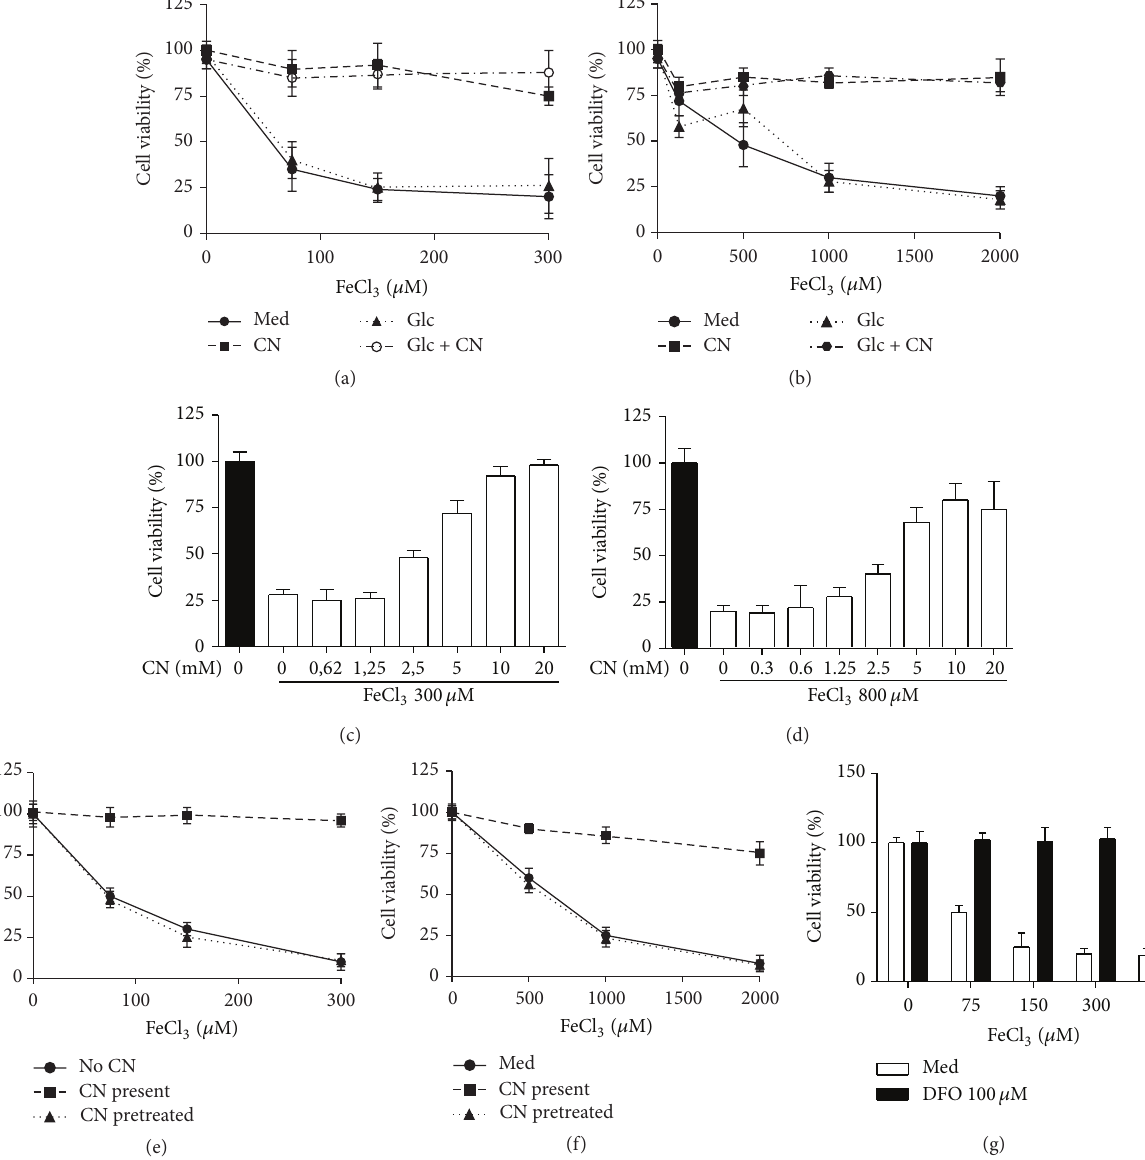
Figure 2: Influence of high glucose and carnosine on iron mediated toxicity in HUVECs (a, c, and e) and PTECs (b, d, and f). High glucose concentration neither increased cell susceptibility to iron nor disrupted the protective effect of carnosine on iron toxicity in HUVECs (a) and PTECs (b). The protective effect of carnosine showed a clear dose-dependent relation in both HUVECs (c) and PTECs (d). Carnosine was only protective when presented during iron challenge but not when cells were pretreated (e and f). Like carnosine also the iron chelator DFO prevented iron mediated toxicity in HUVEC when iron concentration was less than 600 𝜇 M (g). Med: medium, CN: carnosine, Glc: high glucose, and Glc + CN: high glucose +